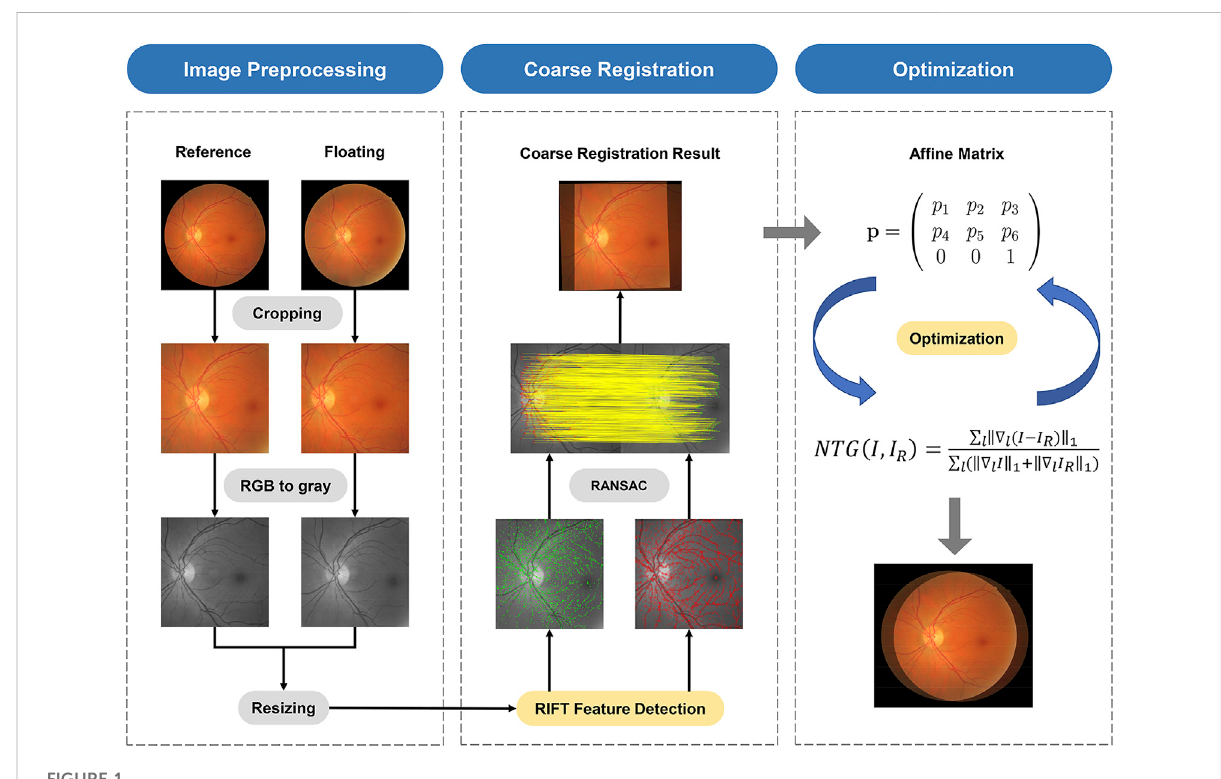
FIGURE 1 Flowchart of the proposed